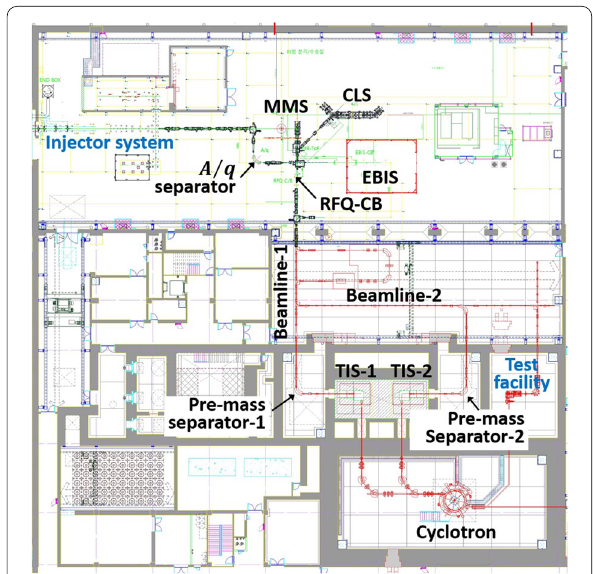
Fig. 7 Schematic of the ISOL